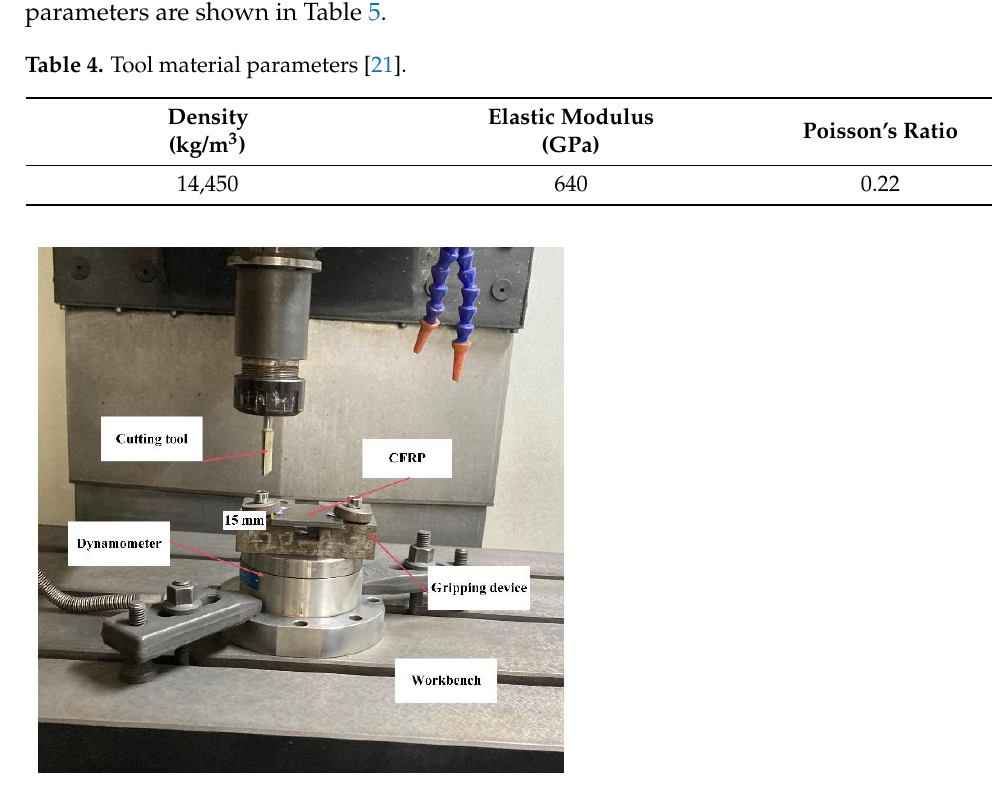
Figure 15. Experimental device layout. Table 4. Tool material parameters [21].